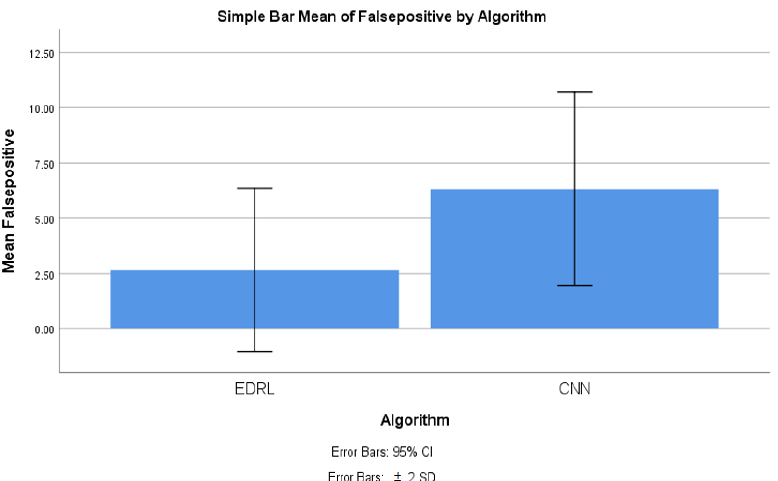
Figure 5. The false positive comparison between the EDRL and CNN algorithms with stand error bars with SD and confidence interval.